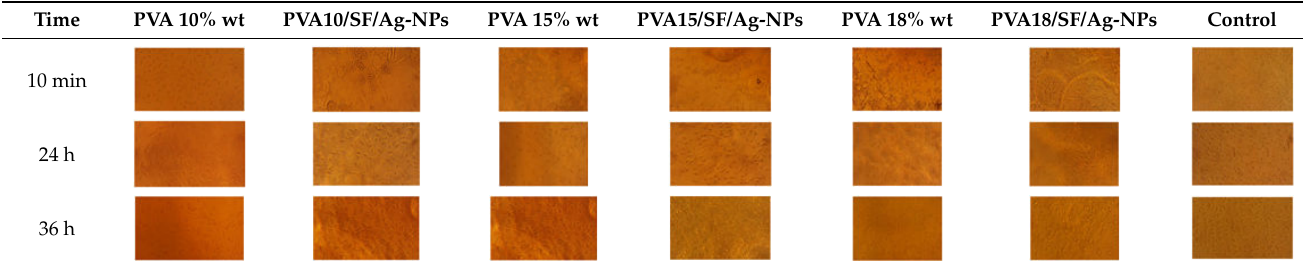
Table 3. Optical micrographs of MG-63 cells in contact with PVA membranes at times of 10 min, 24 h, and 36 h.